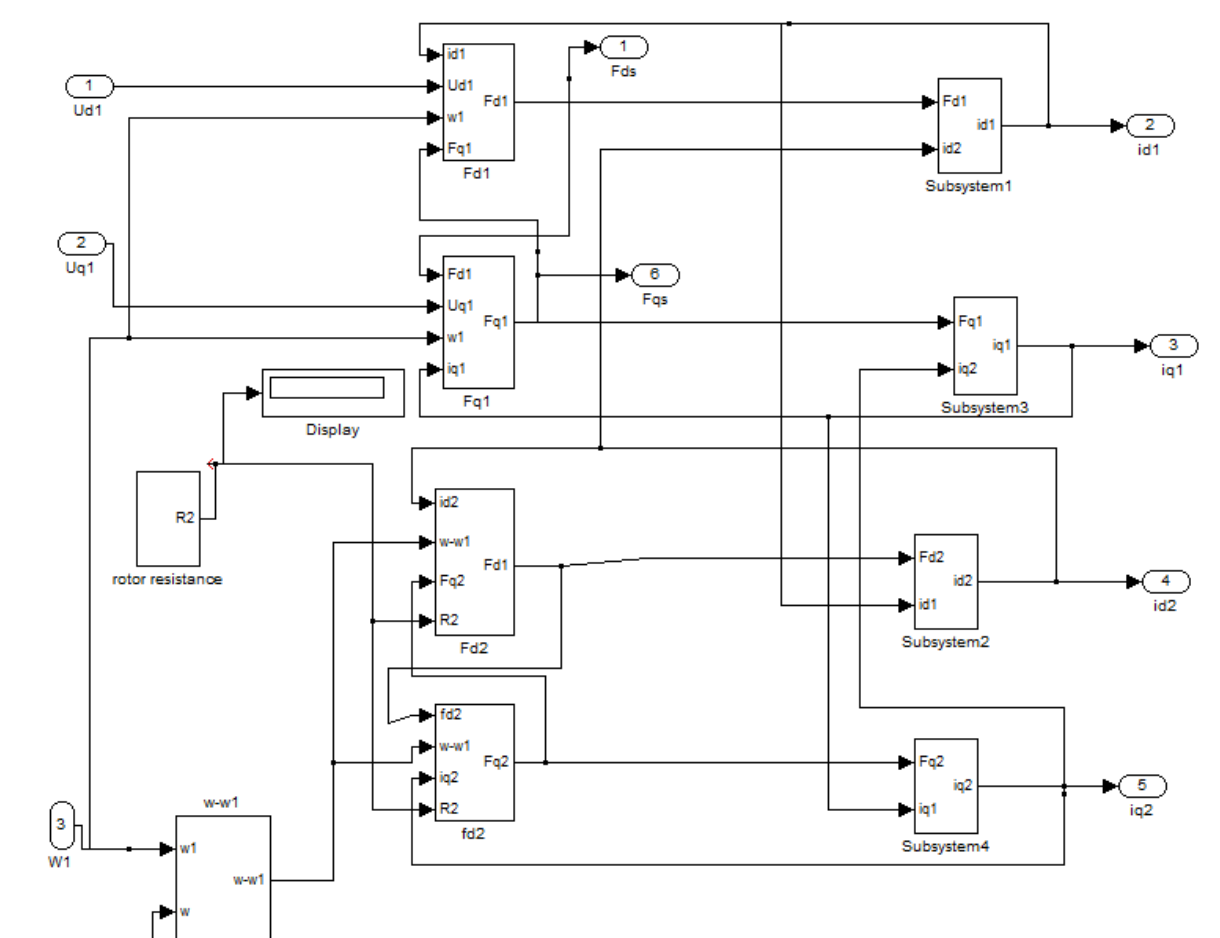
Figure 5. Sub-block of the stator faults.